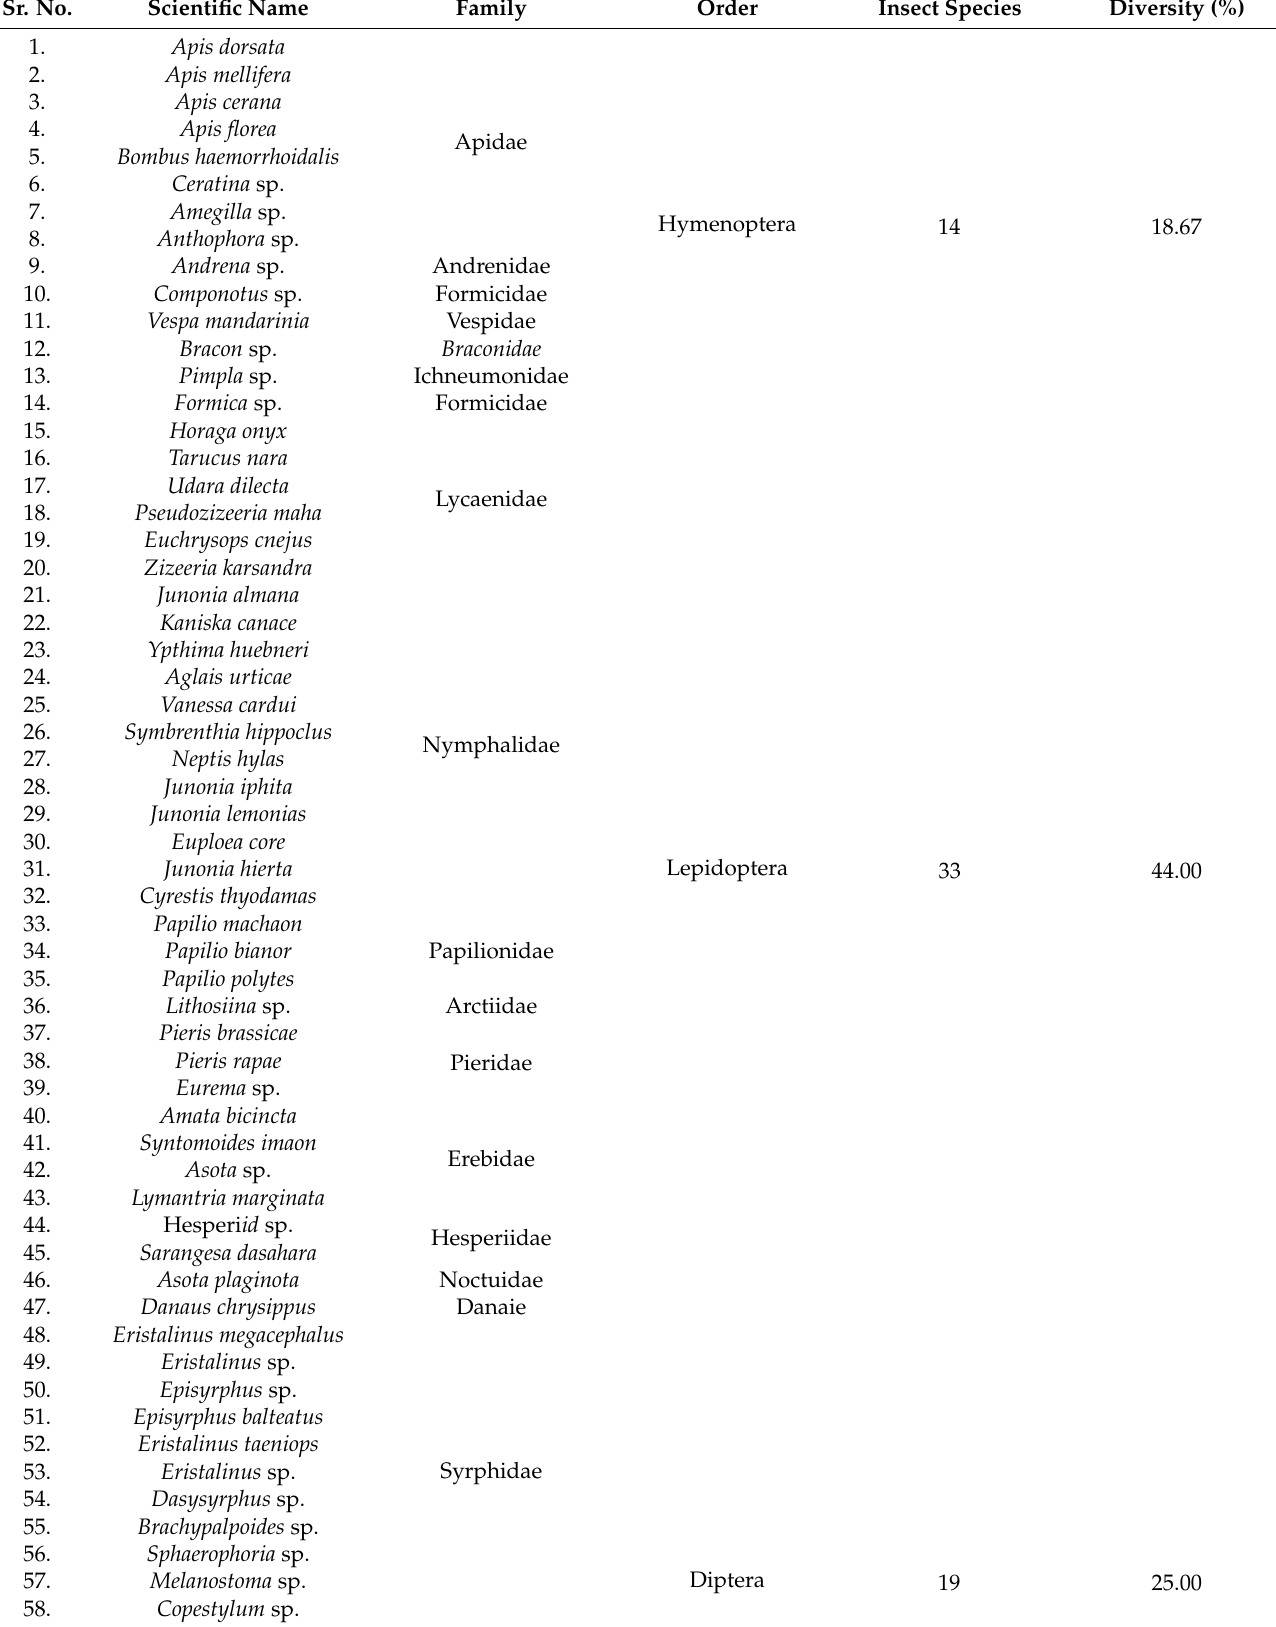
Table 1. List of insect pollinators/visitors in L.